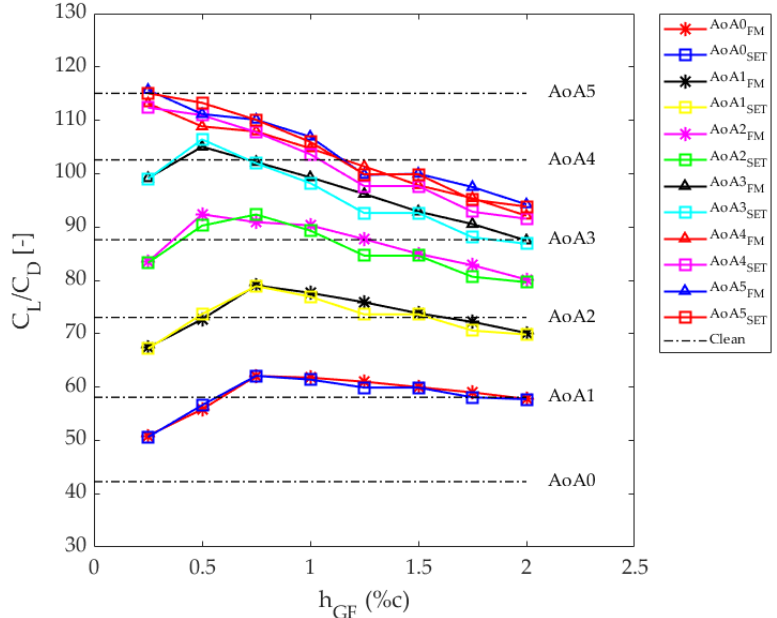
Figure 5. Lift-to-drag ratio (C L / C D ) along the GF lengths for angles of attack (AoAs) from 0 ◦ to 5 ◦ . Quantitative comparison of the C L / C D ratio among the clean airfoil, fully mesh (FM) model and cell-set (SET) model. Square markers have been used to represent the cell-set curves.